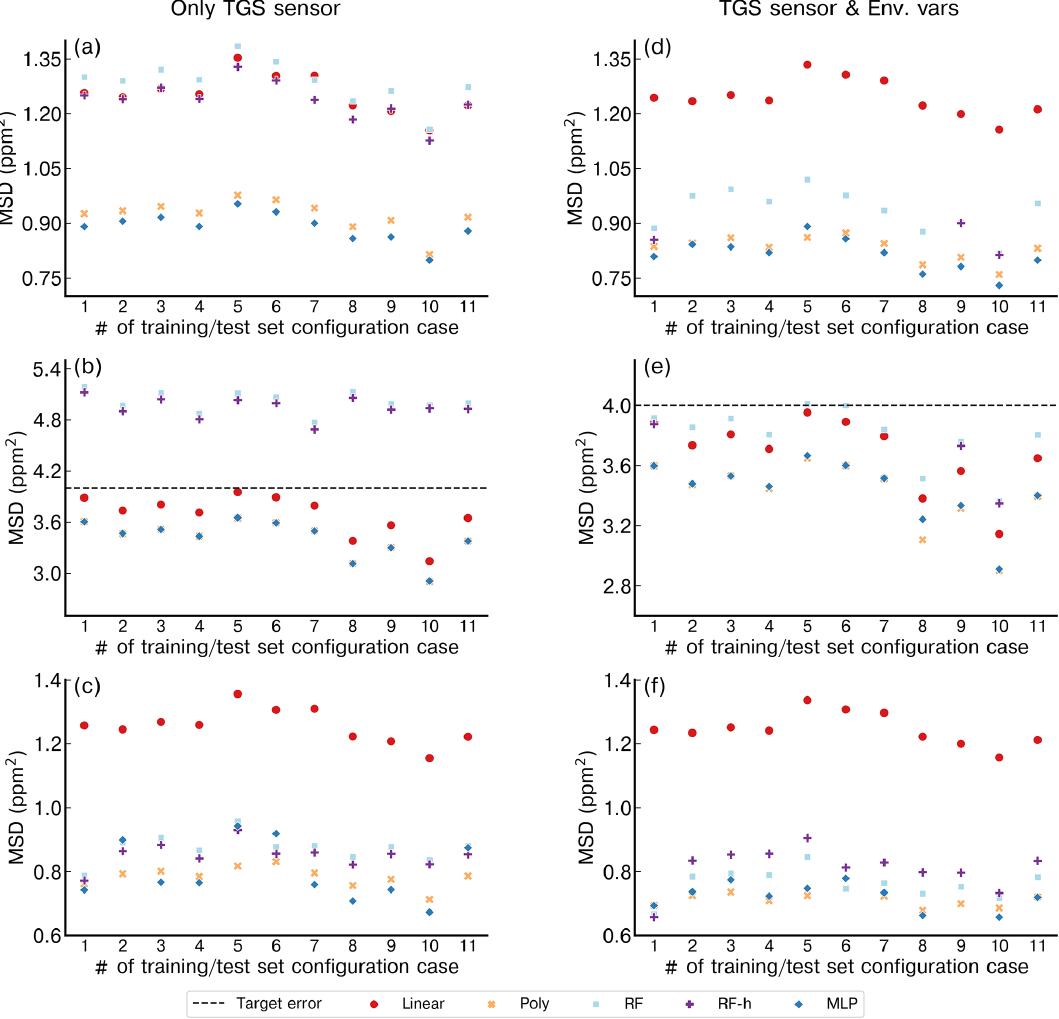
Figure 9. Performance of each model for the different configurations of training and test set (1 to 11 in the x axis) considering the identified clusters. (a) Only Figaro ® TGS 2611-C00 data as input. (b) Only TGS 2611-E00 data as input. (c) Data with both Figaro ® sensors as input. (d) TGS 2611-C00 data and environmental variables. (e) TGS 2611-E00 and environmental variables. (f) Both TGS sensors and environmental variables. Note the different y axis for panels (b) and (e)